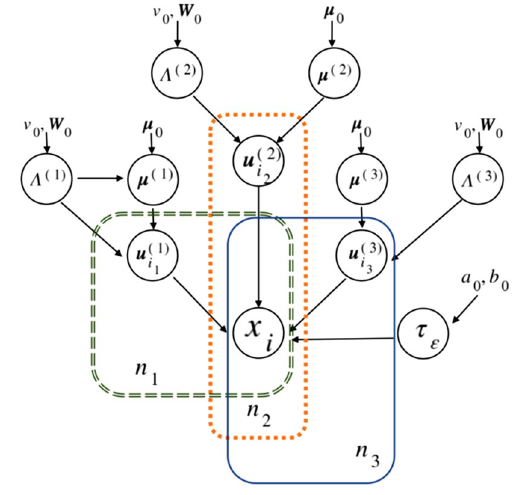
Fig. 4 Schematic diagram of Bayesian model data